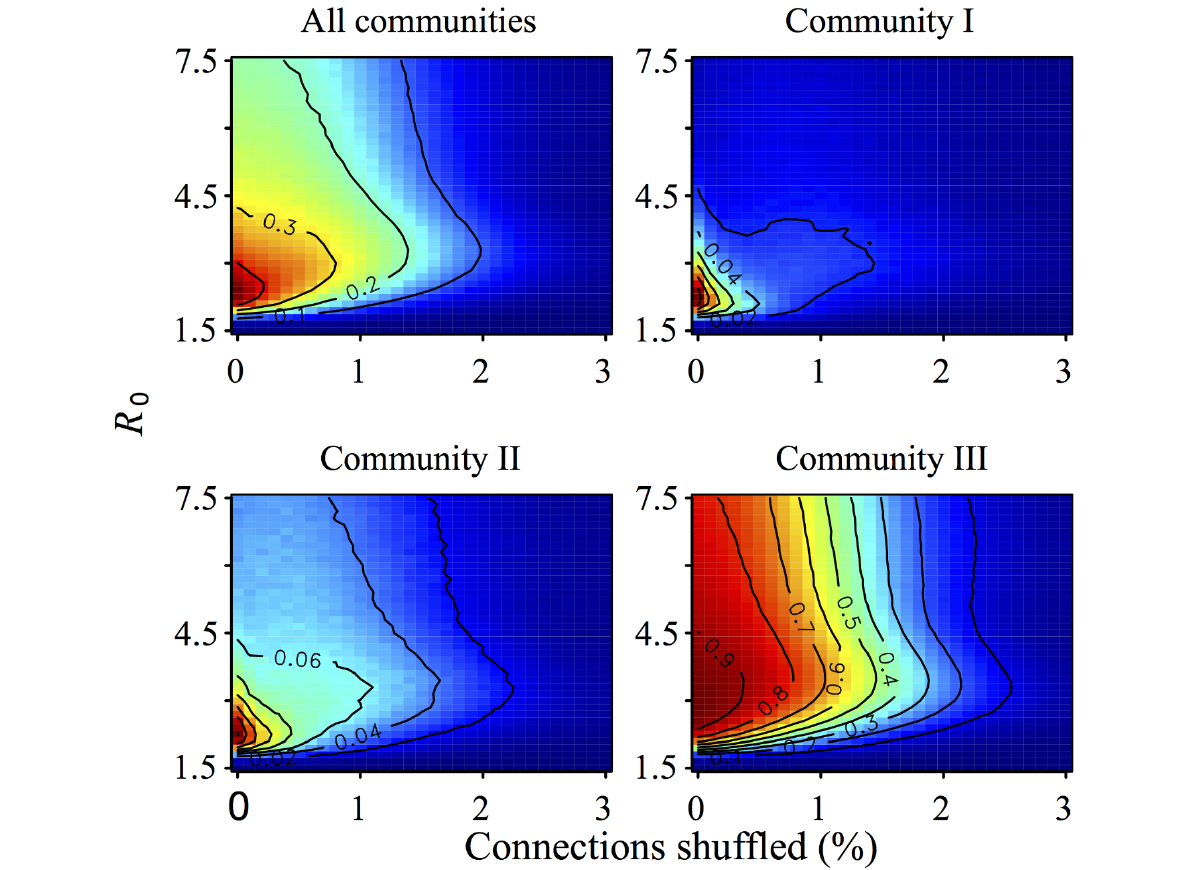
Figure 6. The frequency of multiwave epidemics at varying values of R 0 and network shuffling with warm colors indicating a higher proportion of multiwave epidemics and cool colors indicating a low proportion of multiwave epidemics (frequency values indicated on contours). Frequencies were calculated across all epidemics (top left) and stratified by starting community (top right and bottom). Each pixel is based on 81,920 simulated epidemics originating in the specified community (10 simulations on each of 8192 uniquely shuffled networks).